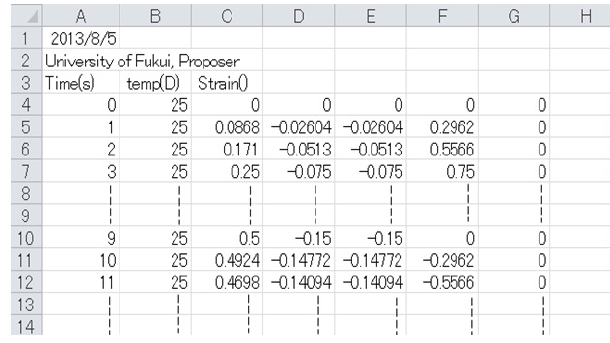
Figure 11: Calculation flow in the program. Figure 13: Formatted input